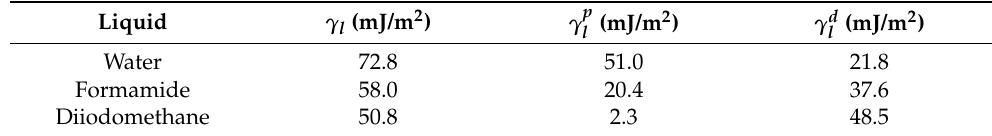
) and dispersive ( γ d ) components of the l l